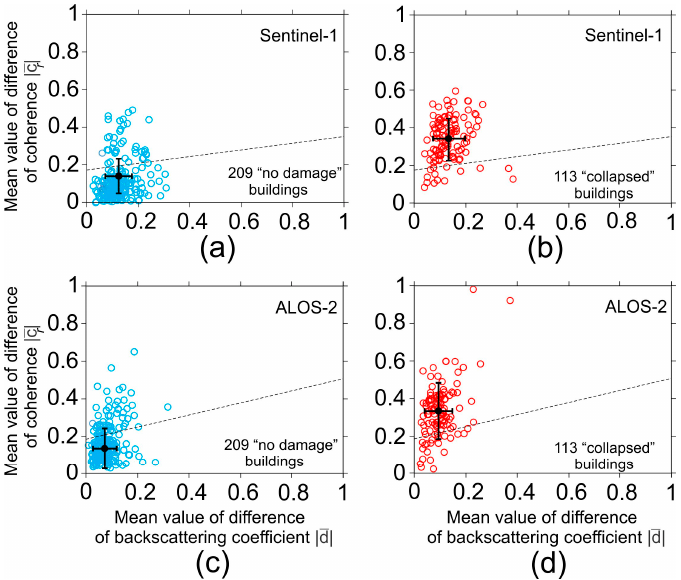
Figure 7. Comparison of (cid:3627)(cid:1856)̅(cid:3627) and |(cid:1855)̅ (cid:3045) | in ( a ) Sentinel-1 ‘no damage’ buildings; ( b ) Sentinel-1 ‘collapsed’ buildings; ( c ) ALOS-2 ‘no damage’ buildings; and ( d ) ALOS-2 ‘collapsed’ buildings. The dashed discriminant lines were deduced from the relative discriminant analyses. The solid black circles are the average values, and the error bars show the standard deviations.